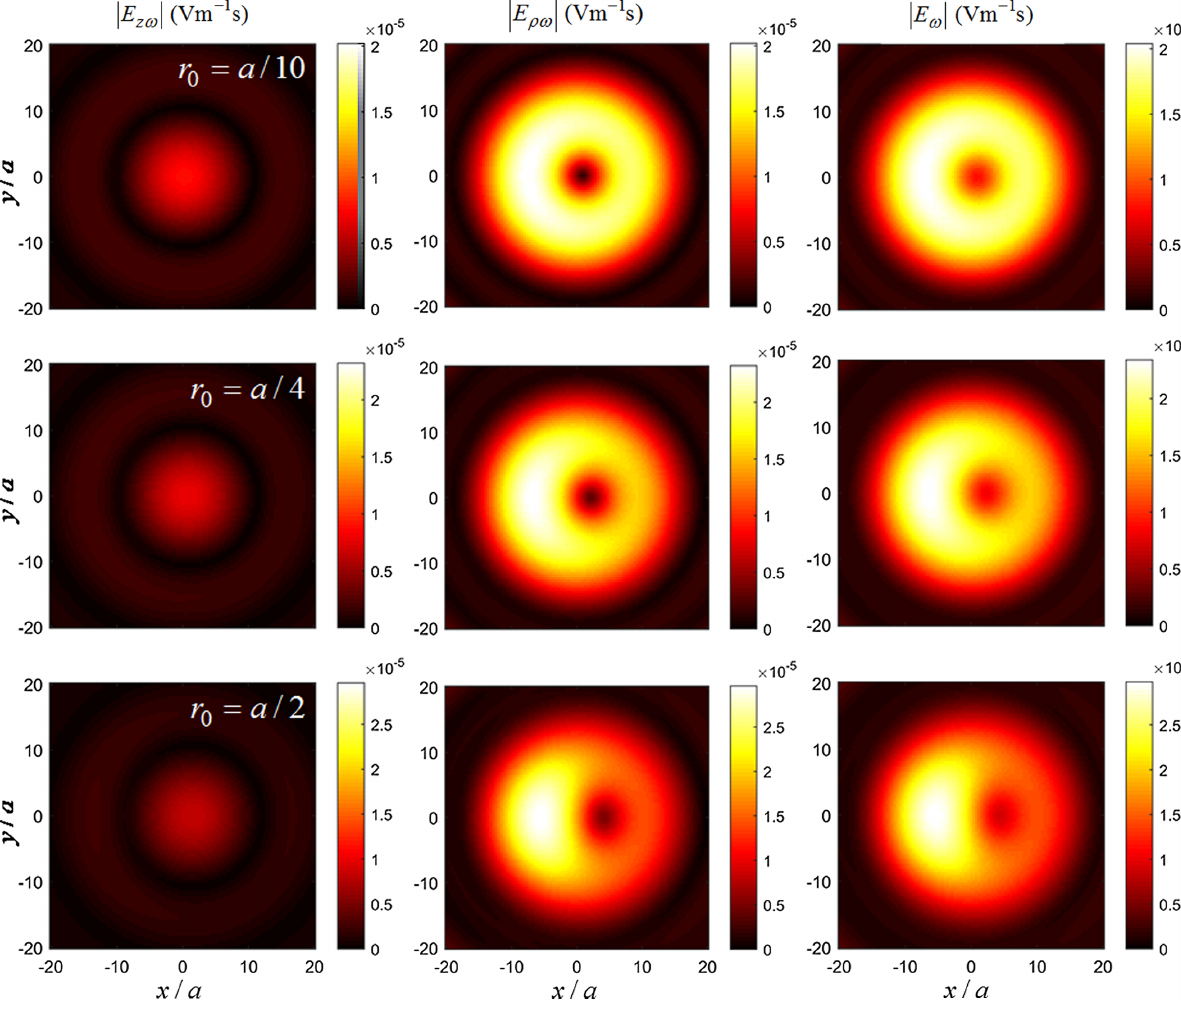
FIG. 1. Two dimensional distribution of absolute values of longitudinal ( E z ω ) and transverse ( E ρω ) and total field over xy -plane in the focal plane of the concentrator ( z ¼ 0 ) for three values of charge ’ s shift r 0 ¼ a= 10 ; a= 4 ; a= 2 . Calculation parameters are given in the paper. Published by the American Physical Society under the terms of the Creative Commons Attribution 4.0 International license. Further distribution of this work must maintain attribution to the author(s) and the published articles title, journal citation, and DOI. 2469-9888 = 19 = 22(10) =